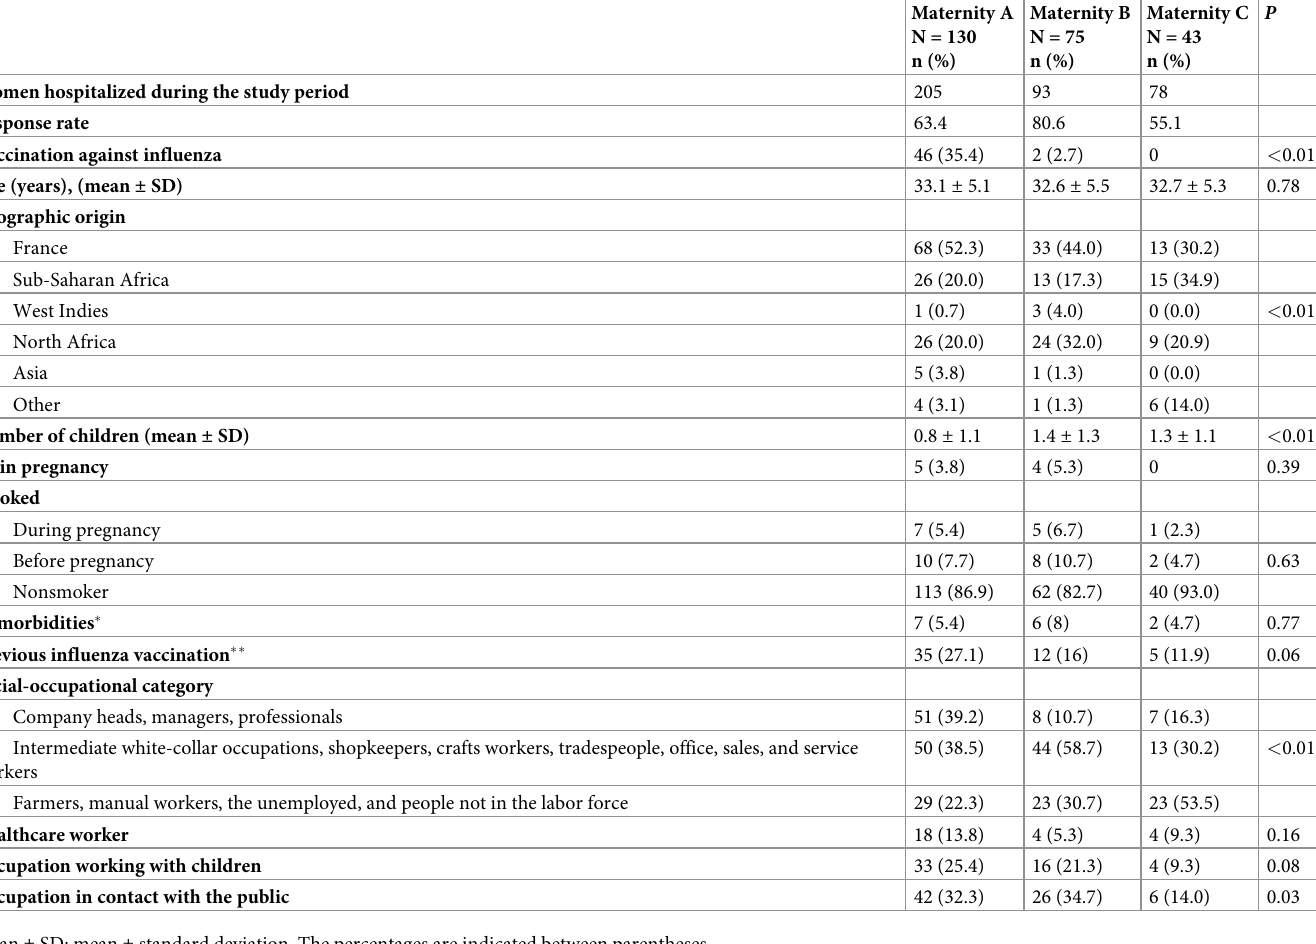
Mean ± SD: mean ± standard deviation. The percentages are indicated between parentheses. � chronic cardiac, pulmonary, hepatic, renal or hematologic disease, hemoglobin disorder, diabetes, cancer, and immune deficiencies, including HIV. �� Two women did not answer this